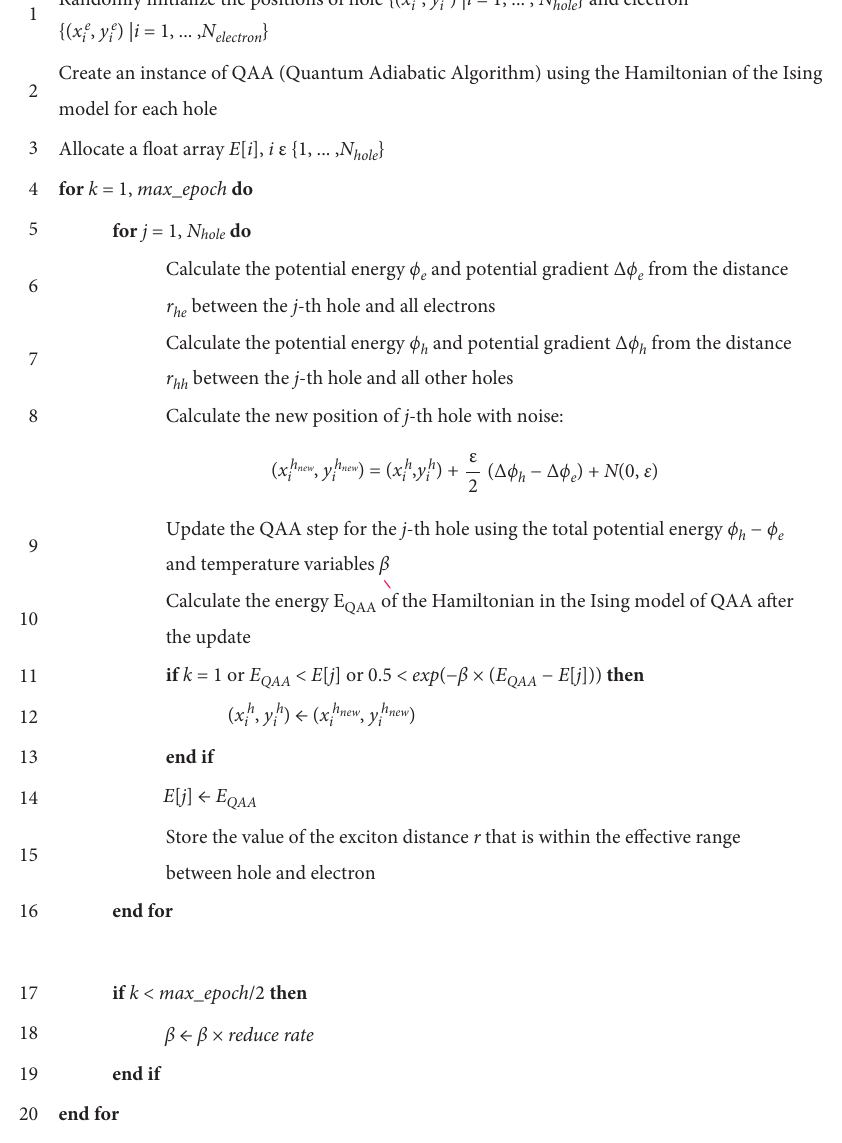
Algorithm: Phase Transition Simulation by Hybrid Quantum Classical Algorithm